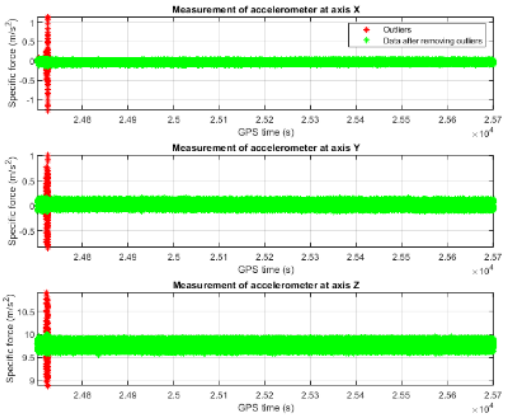
Figure 7 .Accelerometer measurements after removing outliers